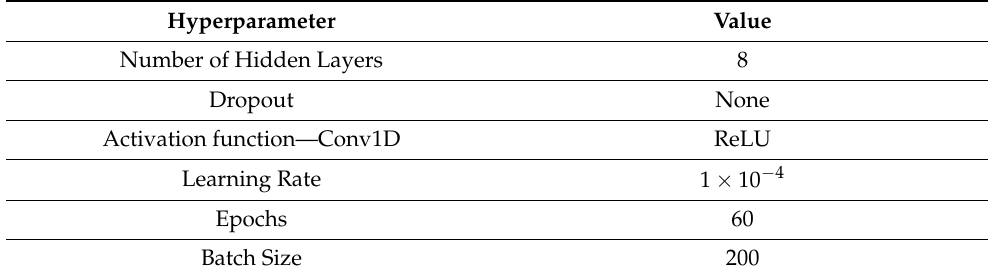
Table 2. CNN hyperparameters.